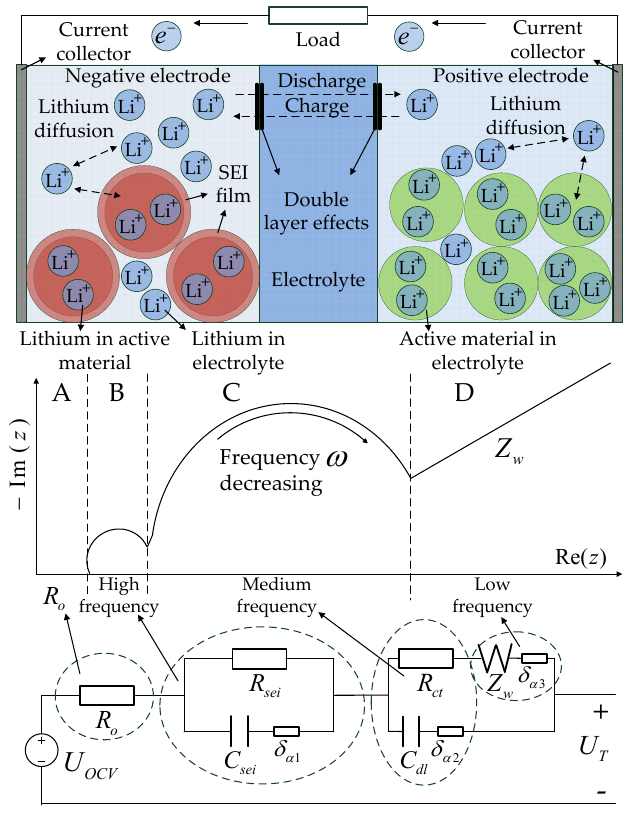
Figure 1. Schematic diagram of the lithium-ion battery internal dynamic phenomena, the corresponding EIS Nyquist curve and equivalent fractional ‐ order impedance circuit.